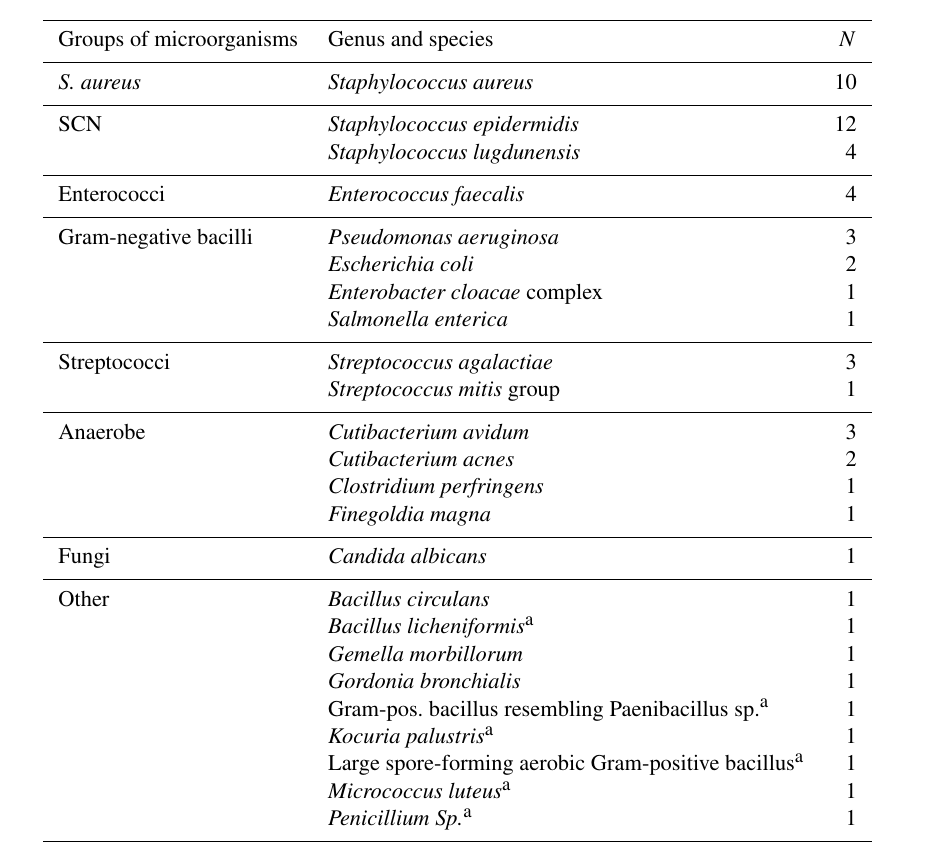
Table 7. Microorganisms isolated from aspiration cultures (SCN represents staphylococcal negative).